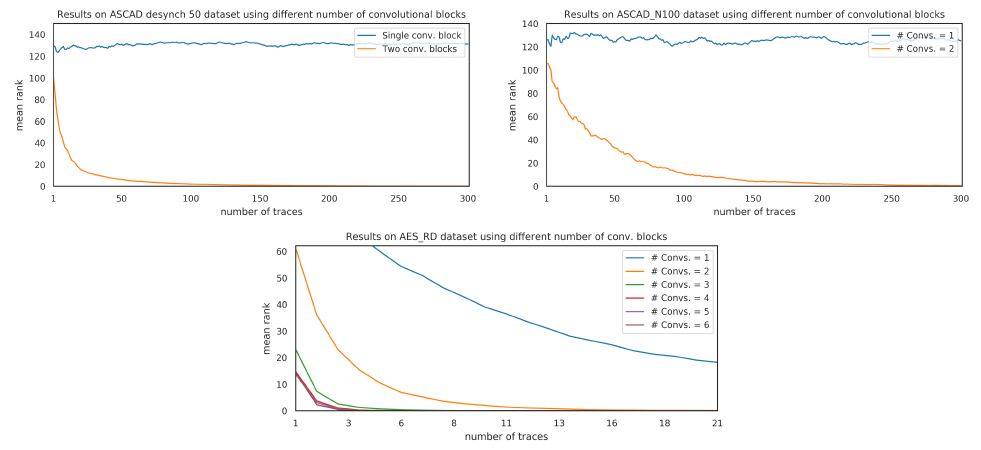
Figure 9: Effect of the number of convolutional blocks on the performance of a network when attacking the datasets ASCAD_N50 (left) and ASCAD_N100 (right), using the model Simplified